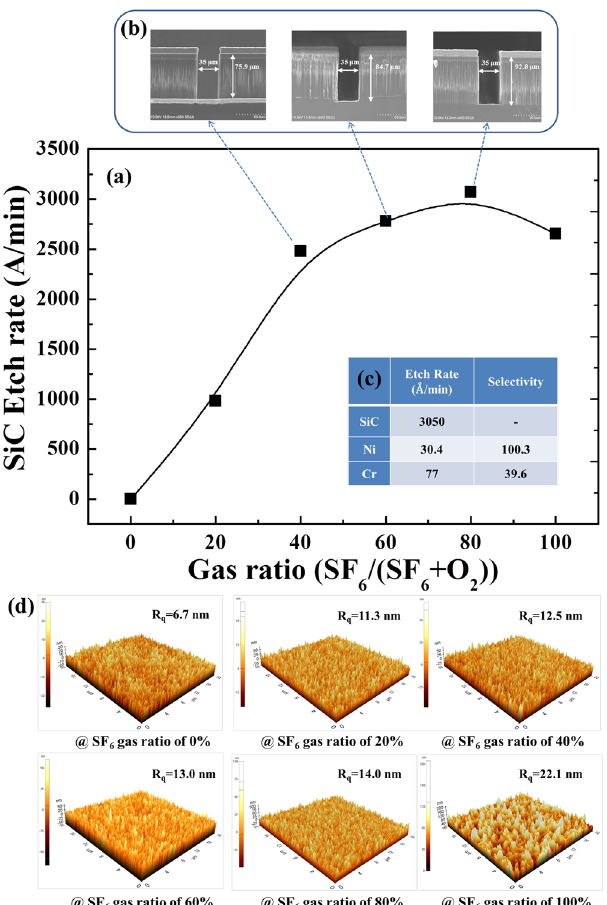
Figure 1. Etching and selectivity profile of the SF 6 + O 2 gas mixture. ( a ) Etching rate characteristics of the SF 6 + O 2 gas for different ratios. (b) Cross-sectional image of the etched SiC based on different gas ratio. (c) Etching rate and selectivity results for Ni and Cr metal masks, with a fixed SiC etching rate of 3050 Å/min. ( d ) AFM image of the etching surface at different ratios of SF 6 + O 2